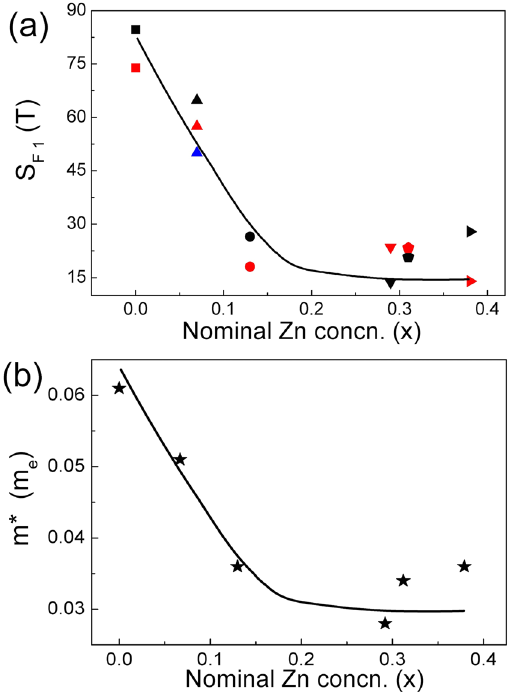
Figure 6. Panel (a): The main frequency of the SdH oscillations at 2 K for (Cd 1 − x Zn x ) 3 As 2 . Different colors represent different samples from the same batches. The black ones are the samples corresponding to Figs 4(a) and 7(b). Panel (b): The cyclotron effective mass m * according to the main frequency for each sample versus x. The line is for visual